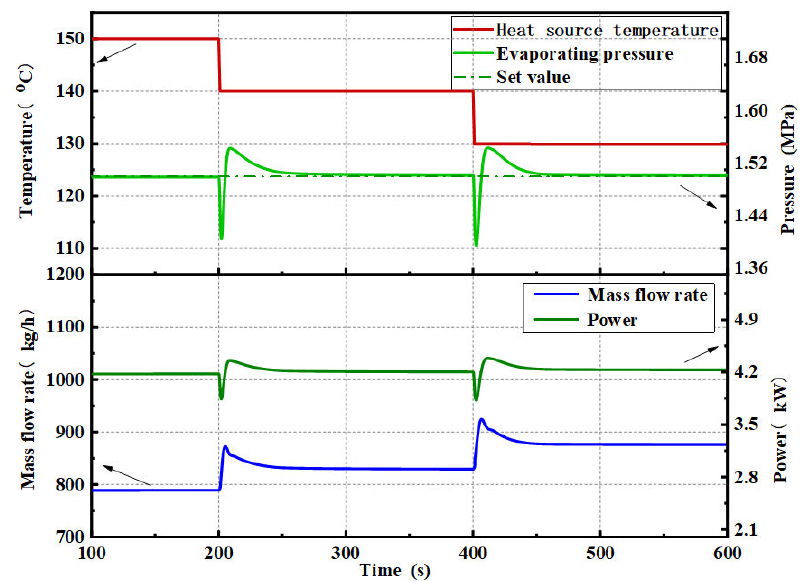
Figure 11. Dynamic response of key operating parameters under the CEP